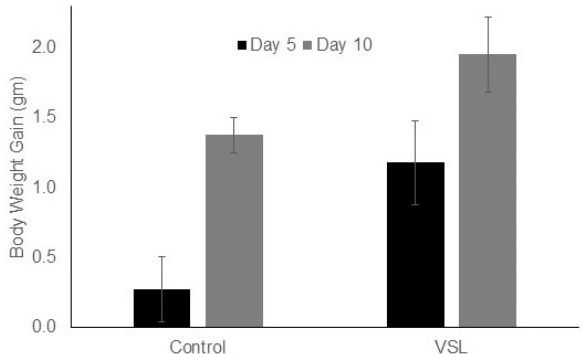
Figure 1. Effect of VSL on mice bodyweight gain in grams after five and 10 days of administration. VSL treatment shows an increasing trend in bodyweight gain after treatment but was not statistically significant when compared to control. Data from seven control and seven VSL-mice are presented as mean ± SD.